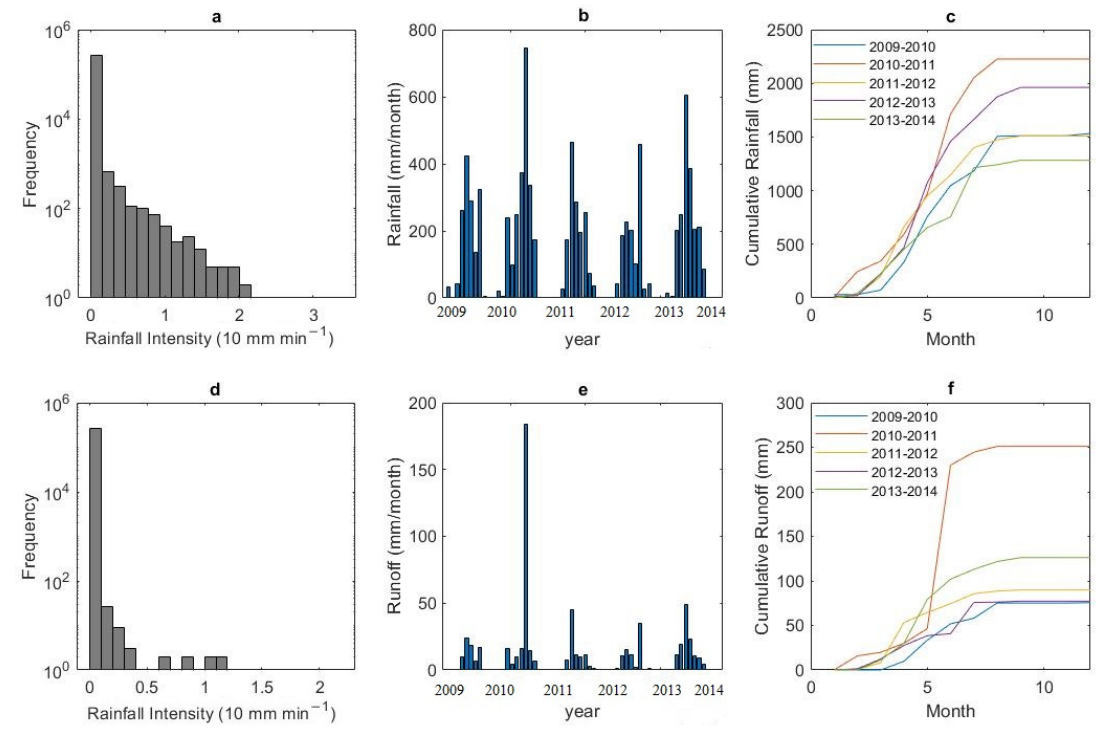
Water 2021 , 13 , x FOR PEER REVIEW 9 of 24 Figure 4. ( a ) Rainfall intensity histogram, ( b ) rainfall time series, ( c ) cumulative rainfall for each year (Month 1 is September), ( d ) runoff intensity histogram, ( e ) runoff time series and ( f ) cumulative runoff for each year (Month 1 is September).